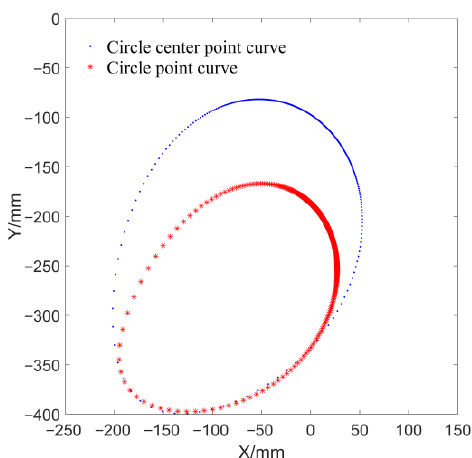
Figure 10. Circle center point curve and circle point curve of the 2R open chain.